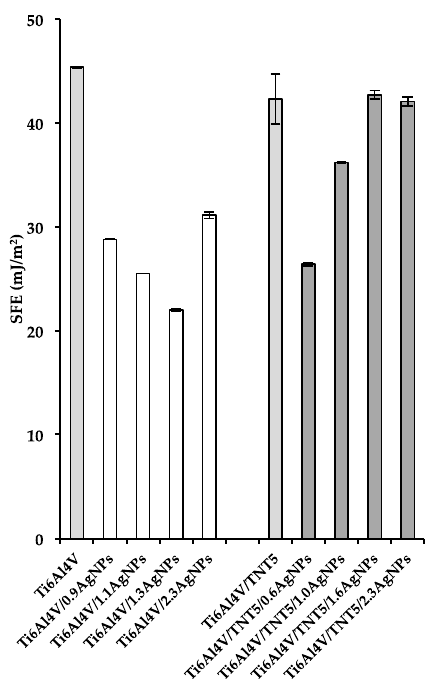
Figure 6. The surface free energy values for Ti6Al4V, Ti6Al4V/AgNPs, Ti6Al4V/TNT5, and Ti6Al4V/TNT5/AgNPs.